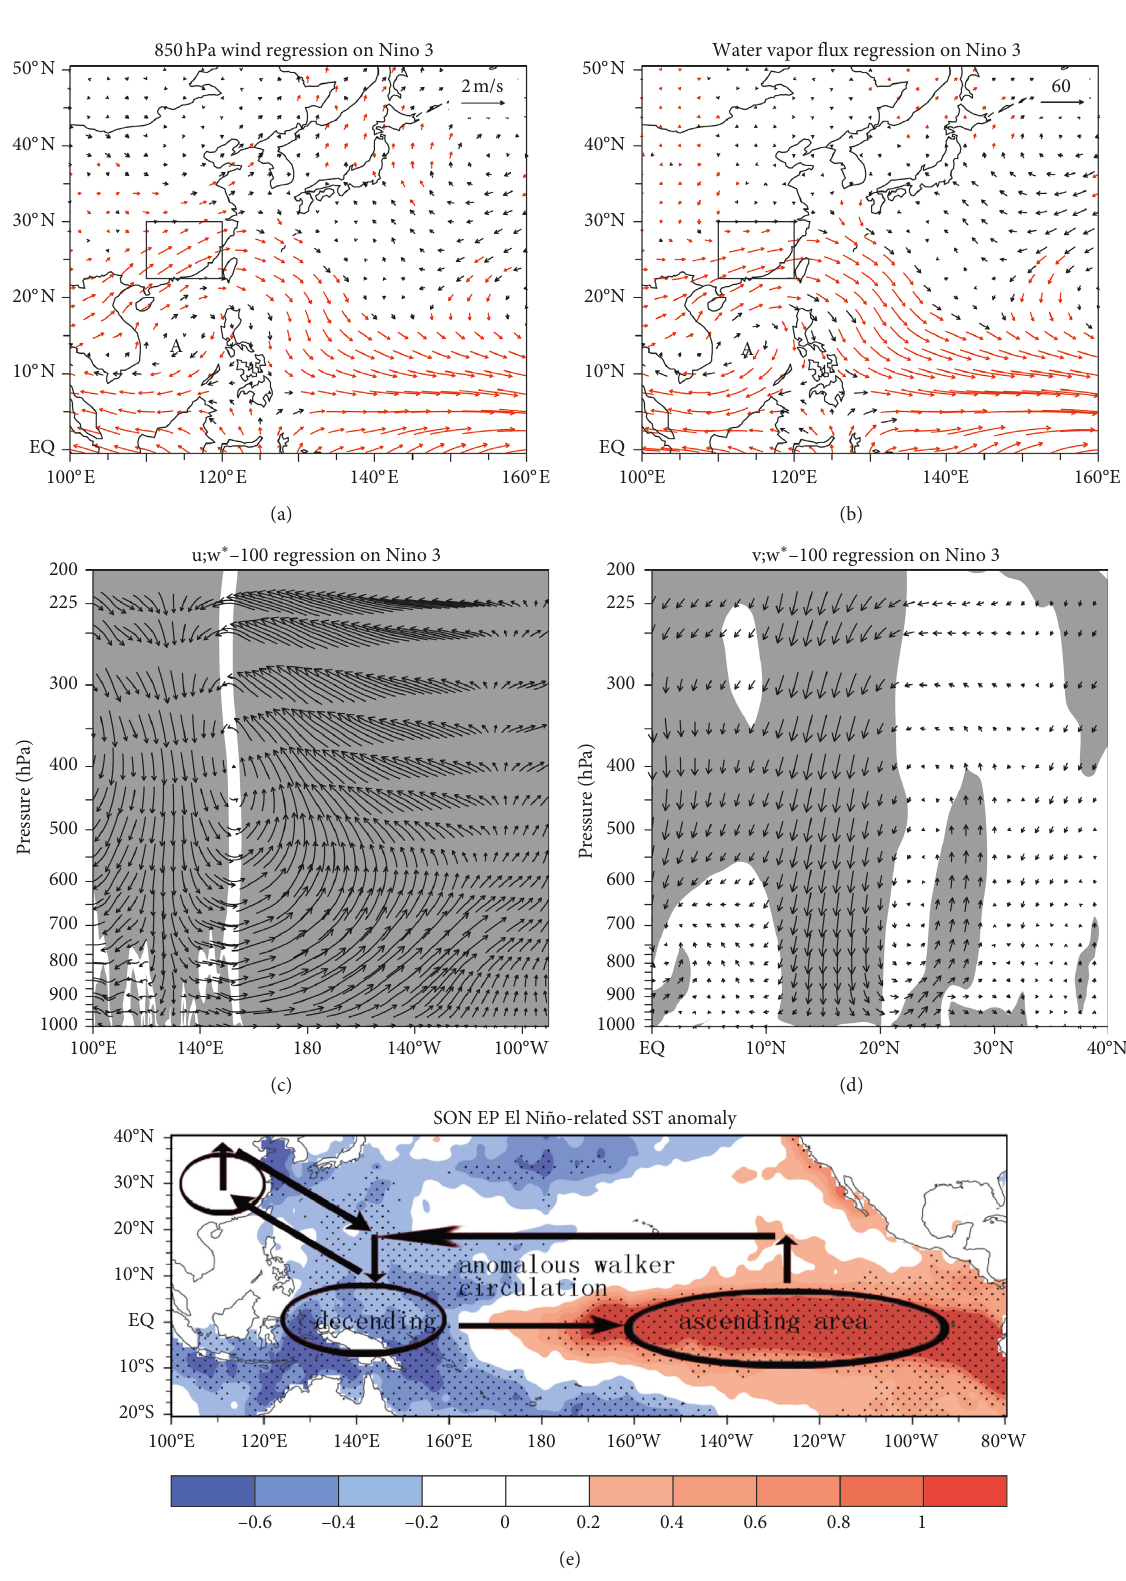
Figure 6: (a) 850hPa wind field (vector, m · s − 1 ), (b) column-integrated water vapor flux (unit: g · kg − 1 · m · s − 1 ), (c) the regression of zonal wind and vertical velocity (omega multiplied by − 100) cross section along 5 ° S–5 ° N on the Nino 3 index, and (d) the regression of meridional wind and vertical velocity (omega multiplied by − 100) along 110 ° E–120 ° E on the Nino 3 index. Red vector in (a, b) and shadings in (c, d) through significant inspection at the 90% confidence level. (e) Schematic diagram showing anomalous Walker circulation associated with EP ENSO- like SSTA, the latitudinal circulation in tropical Pacific denotes the anomalous Walker circulation and to its northwest side is the anomalous meridional owning the joint descending branch in tropical Western Pacific. The shadings represent the SSTA during the positive phase years of EP ENSO (unit: ° C), and dotted region is the significant area through the 90% significance t